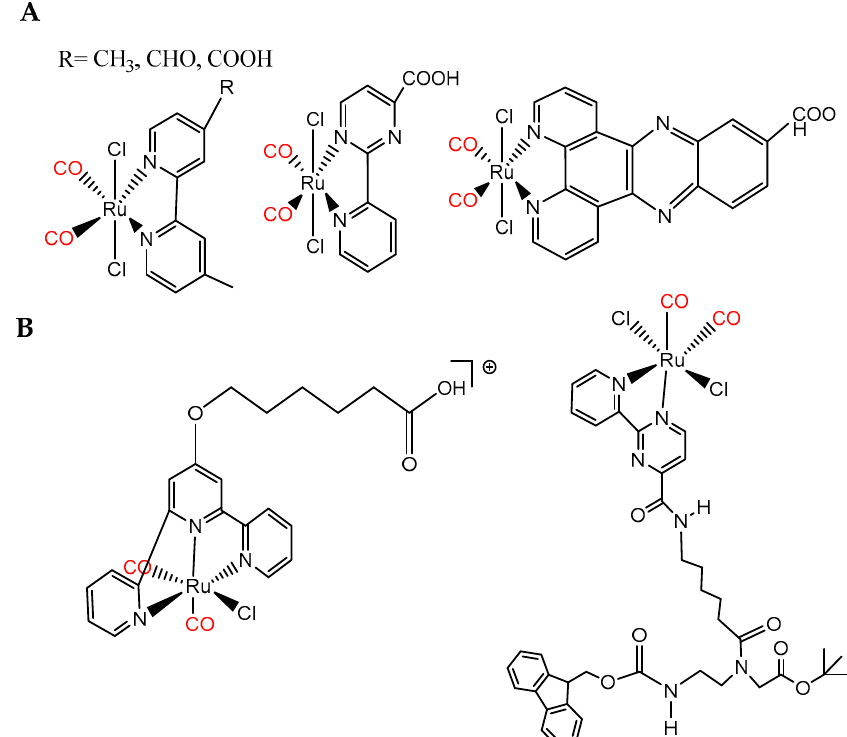
Figure 13. The hydrolytically activated Ruthenium dicarbonyl complexes CORM ‐ 2 and CORM ‐ 3 could be transformed into Photo ‐ CORMats by peptide ligands through different functionalization: (A) Polypyridyl ligand of 2 ‐ (2 ‐ pyridyl)pyrimidine ‐ 4 ‐ carboxylic acide (CppH); (B) monomeric PNA backbone.